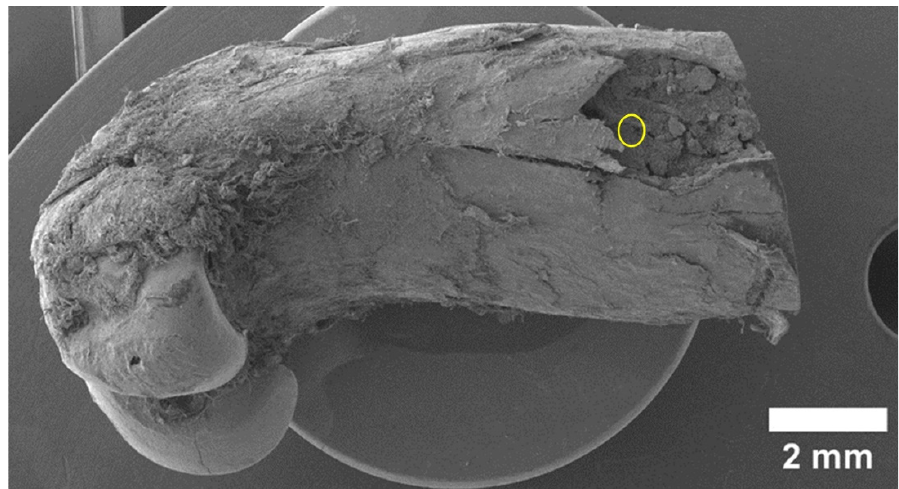
Figure 4. SEM image of bone area at proposed implant site. Spherical discharges are determined on surface of bone tissue. Similar results are found with a bone sample at 6 months (Figure 5). There are no visible traces of implant at the location of implant, and spherical discharges are present (Fig- ure 6).